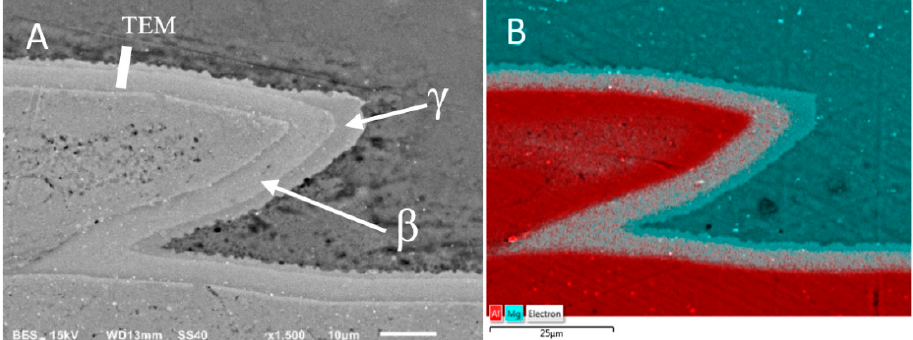
Figure 13. Microstructure of AZ31/AA1050 joint after hot-rolling in 400 °C: ( A ) SEM results, ( B ) Mg and Al elements distribution on the sample surface.